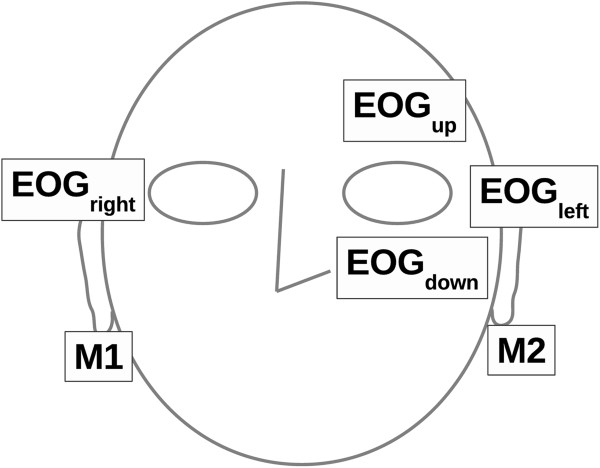
Electrode placement. EOGv is the difference between the voltage recorded by the upper and lower eye electrode (EOGv = EOGup – EOGdown) whereas EOGh is the difference between the voltage recorded by the right and left eye electrodes (EOGh = EOGright – EOGleft).